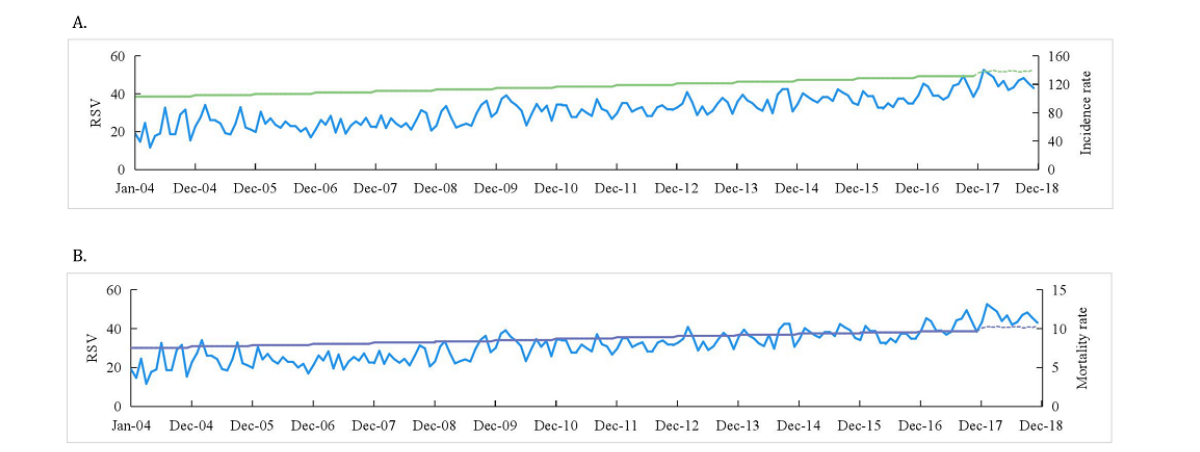
Figure 1. Trends of atrial fibrillation and flutter from 2004 to 2018. (A) Trends of incidence rate and relative search volume (RSV) of atrial fibrillation and flutter from 2004 to 2018. (B) Trends of mortality rate and RSV of atrial fibrillation and flutter from 2004 to 2018. The blue line represents the RSV of each noncommunicable disease from 2004 to 2018, the green line represents the incidence rates, the purple line represents the mortality rates, and the dotted line represents the forecast for morbidity and mortality in